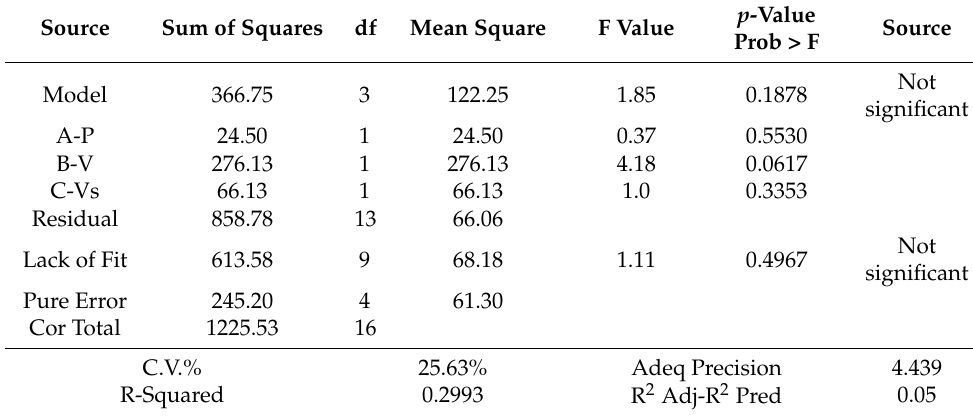
Table 8. Variance analysis of impact absorption energy model.